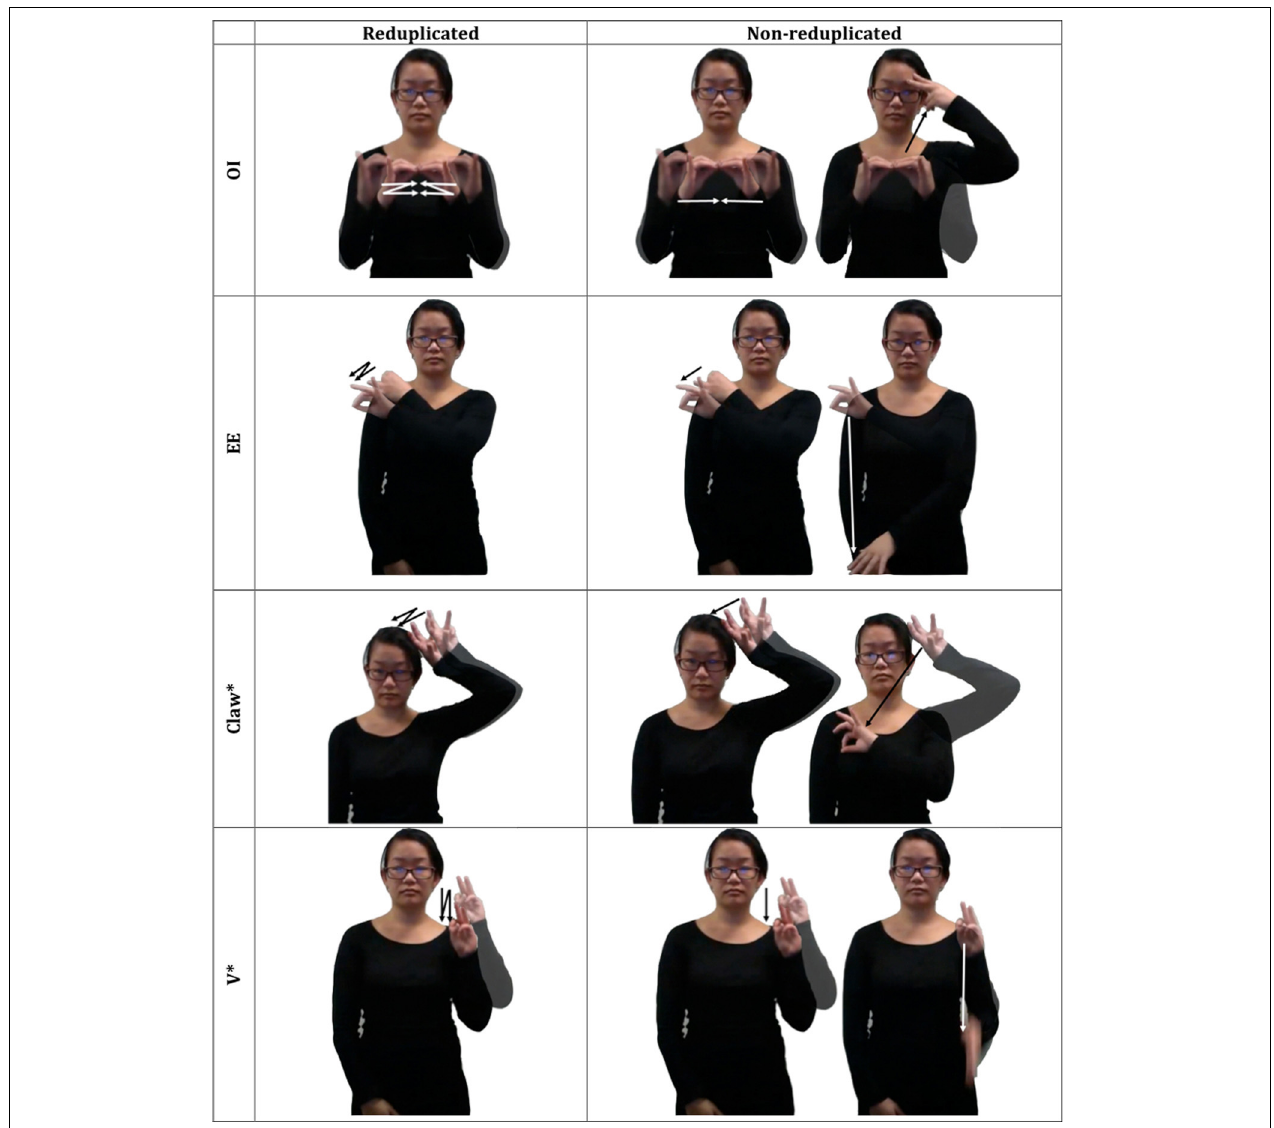
FIGURE 5 | An illustration of the novel signs with unattested handshapes used in Experiments 3,